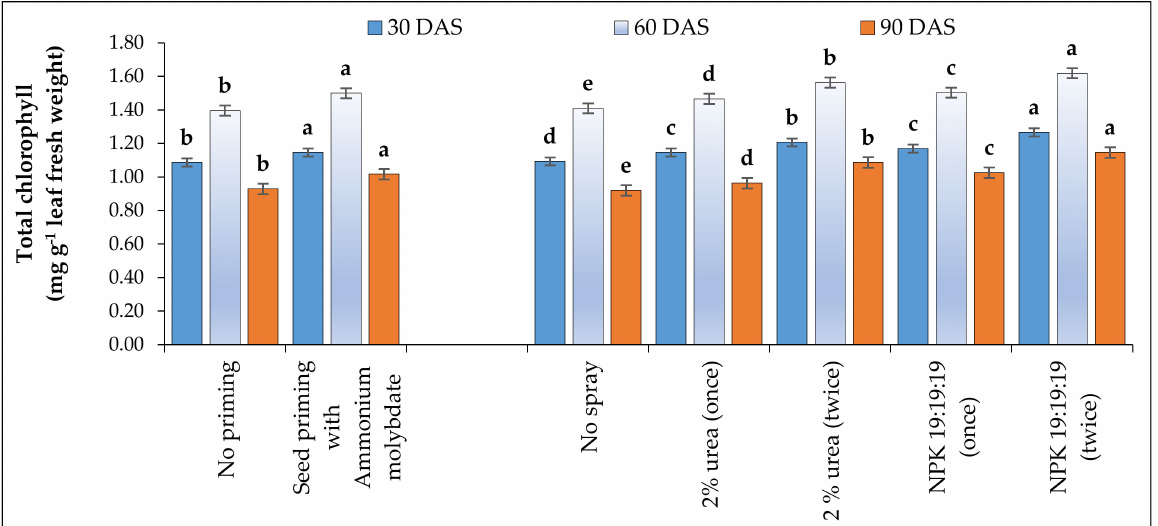
Figure 4. Effect of seed priming and foliar sprays on total leaf chlorophyll content of grass pea at different growth stages (pooled means of 2 years) (Different letters in all bars denote significant differences between